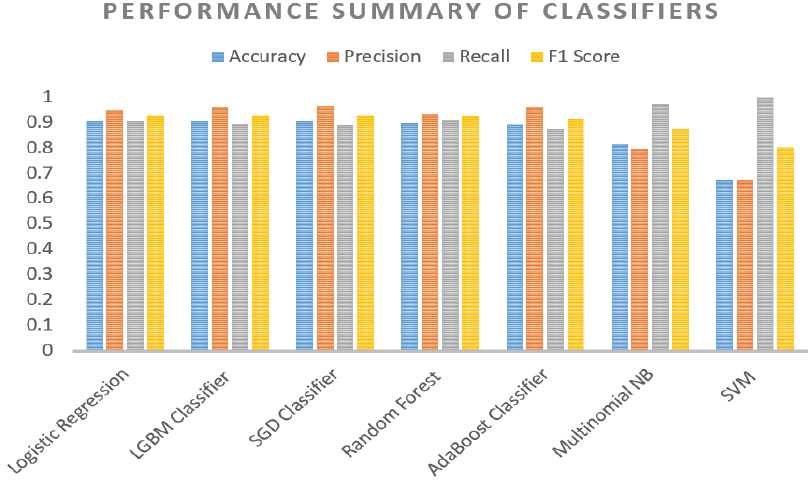
Figure 5. Performance Summary of Algorithms. Table 2. Performance Summary of Algorithms.